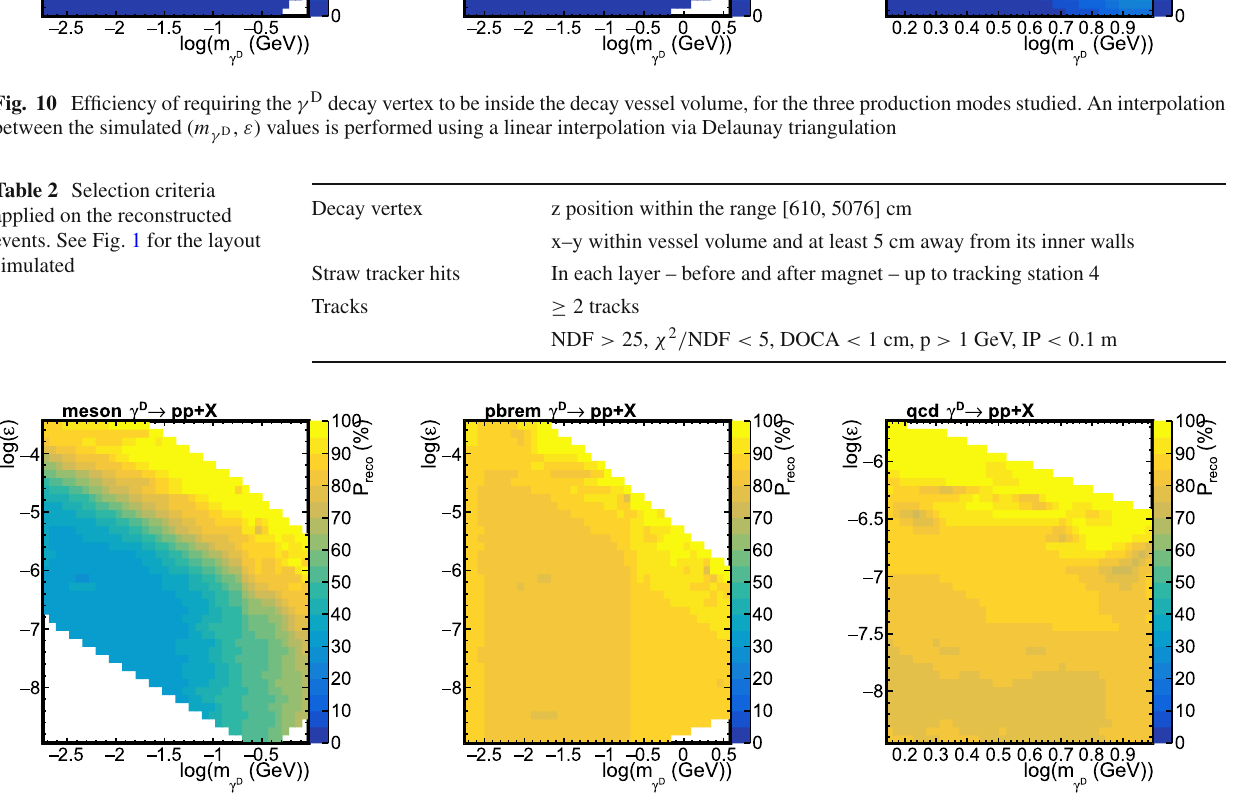
Fig. 11 Efficiencyofrequiringtwogoodtracks,foreventswithtwochargedparticlesand γ D vertexinsidethevesselvolume,forthethreeproduction modes studied. An interpolation between the simulated ( m γ D , ε ) values is performed using a linear interpolation via Delaunay triangulation